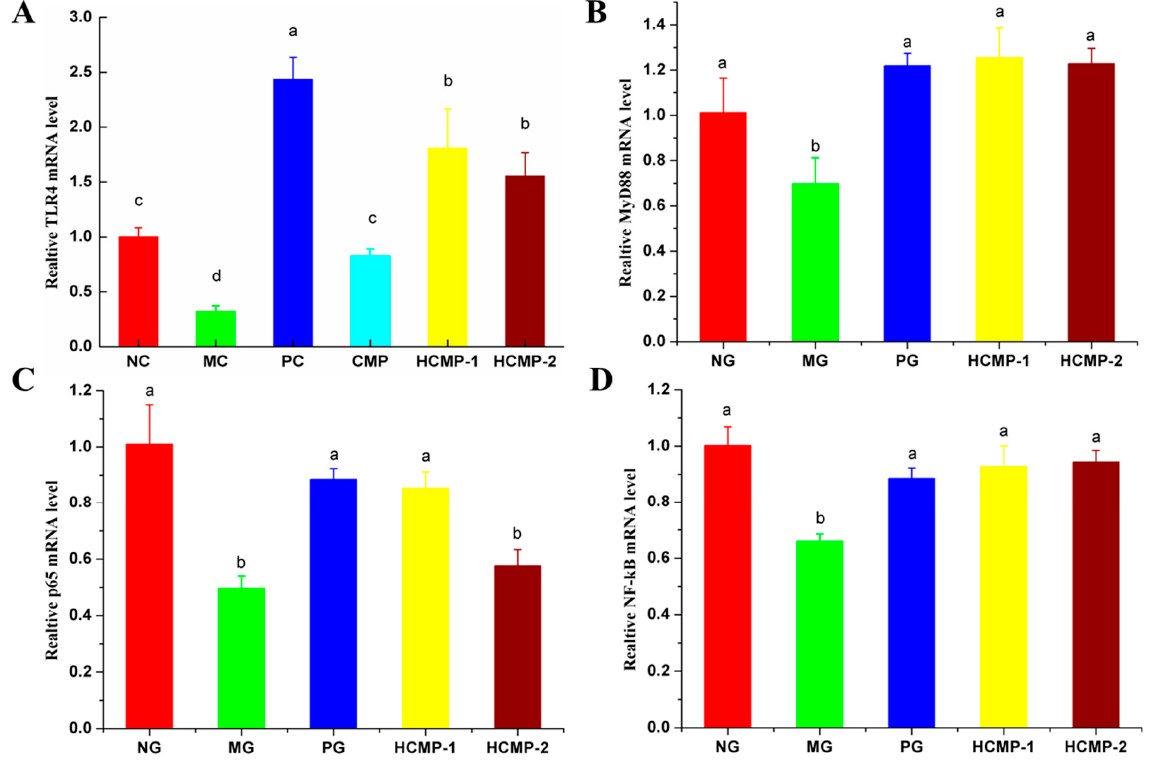
Figure 5. Effects of HCMP-1 and HCMP-2 on the mRNA expression of TLR4 ( A ), MyD88 ( B ), p65 ( C ) and NF- κ B ( D ) in spleen. The significant differences ( p < 0.05) were marked as various superscript small letters (a–d).